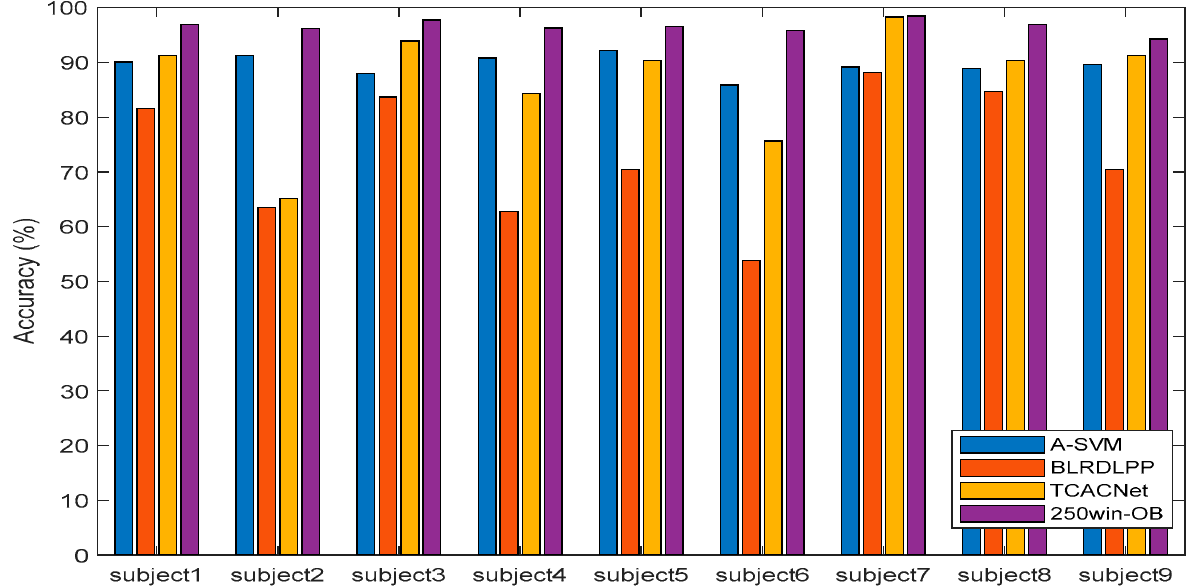
Figure 8. Comparison of accuracy with existing methods and the proposed